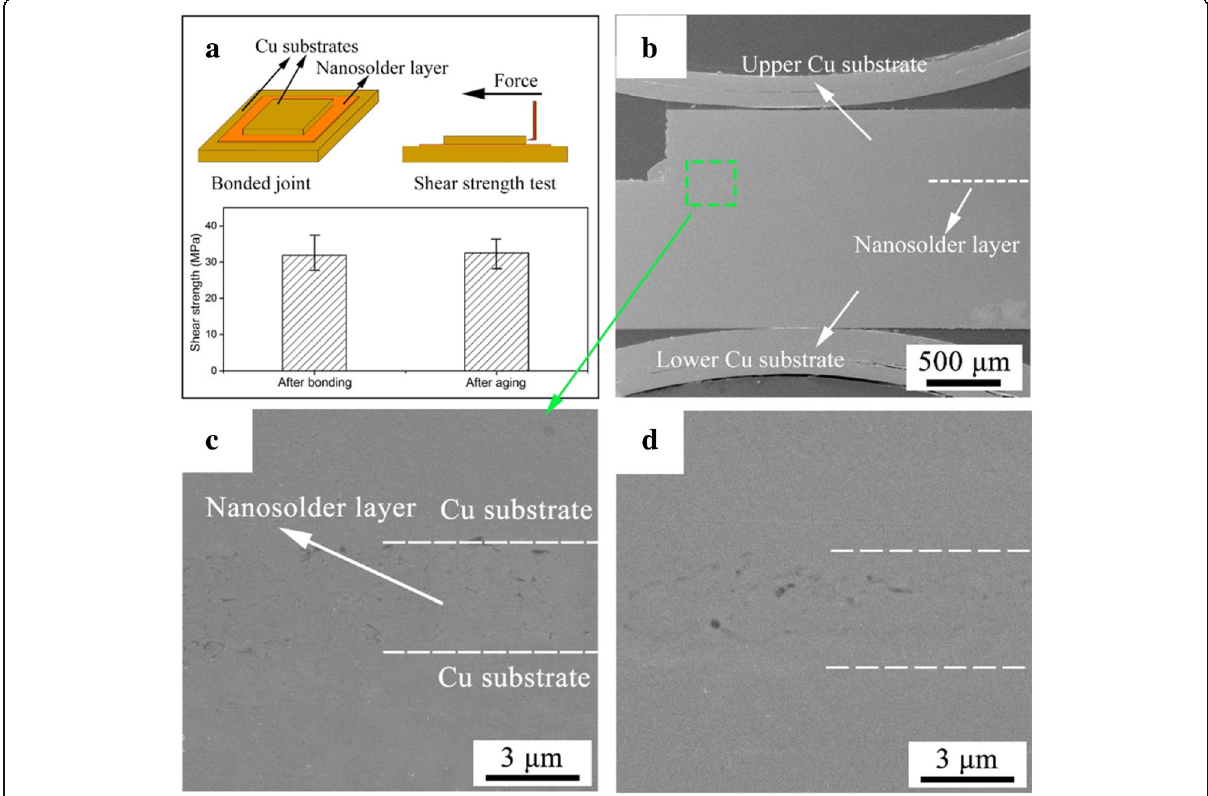
Fig. 3 a The schematic diagram of shear strength test and the tested value of the bonded joint and the aged joint. b The cross-sectional SEM image of the Cu – Cu joint. c The partially magnified bonding interface after bonding at 300 °C for 60 min. d The Cu – Cu bonding interface after isothermal aging at 150 °C for 200